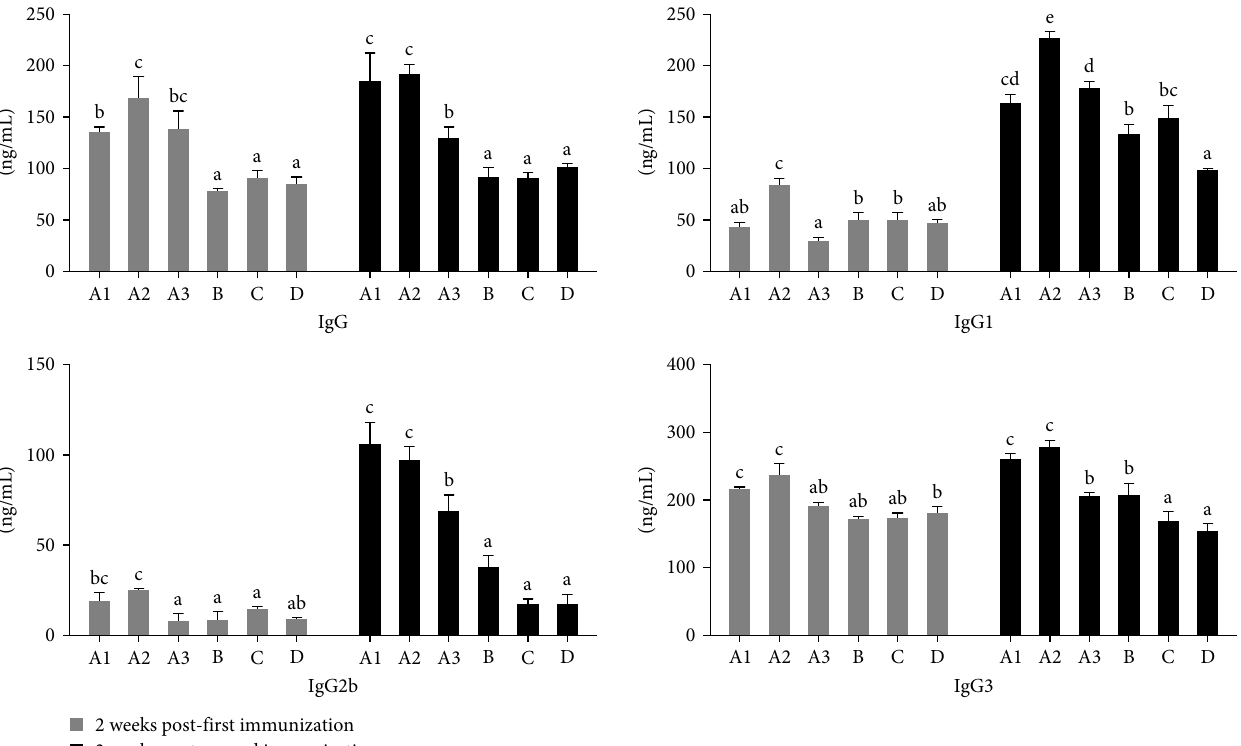
F IGURE 1: The levels of serum IgG and its subclasses. The horizontal and vertical coordinates of the graph stand for the level of antibody and different groups. Different letters above the bar indicate the presence of signi fi cant differences among the groups ( P < 0 : 05). Groups A1, A2, and A3 stand for (ECMS200 μ g-oil, ECMS 400 μ g-oil, and ECMS800 μ g-oil) group. Group B stands for oil group, group C stands for EMCS800 μ g group, group D stands for phosphate buffer saline group. Serum IgG level during 2 weeks post the fi rst immunization was signi fi cantly increased in ECMS-oil groups (A1, A2, A3) compared with oil group (B), ECMS group (C), or control group (D) ( P < 0 : 05). Meanwhile, ECMS 400 μ g-oil group (A2) had a signi fi cantly higher level of serum IgG1 than any other groups during 2 weeks after the fi rst and second immunization ( P < 0 : 05). Moreover, groups A1, A2, and A3 had a markedly higher level of serum IgG2b than any other groups (B, C, D) during 2 weeks post the second immunization ( P < 0 : 05), while serum IgG3 level during 2 weeks post the fi rst and second immunization was substantially elevated in groups A1 and A2 as compared to any other groups (A3, B, C, and D) ( P < 0 :